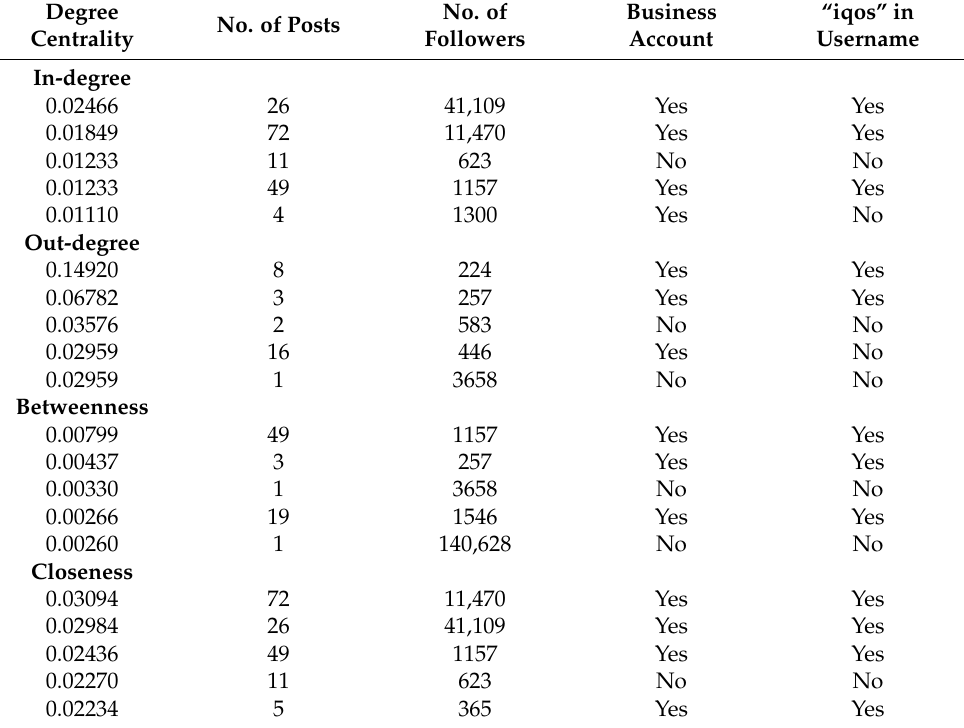
No. of Business “iqos” in Followers Account Username